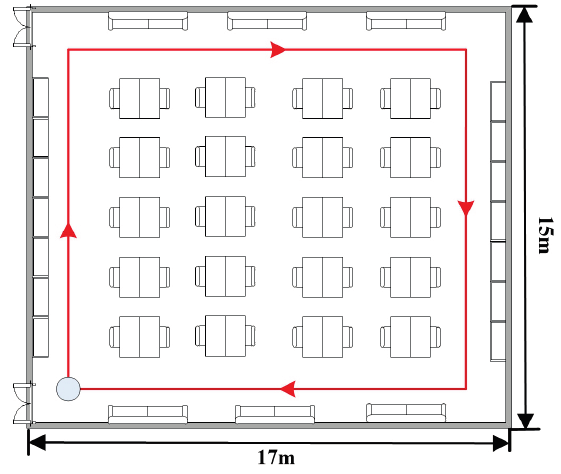
Figure 6. Indoor test